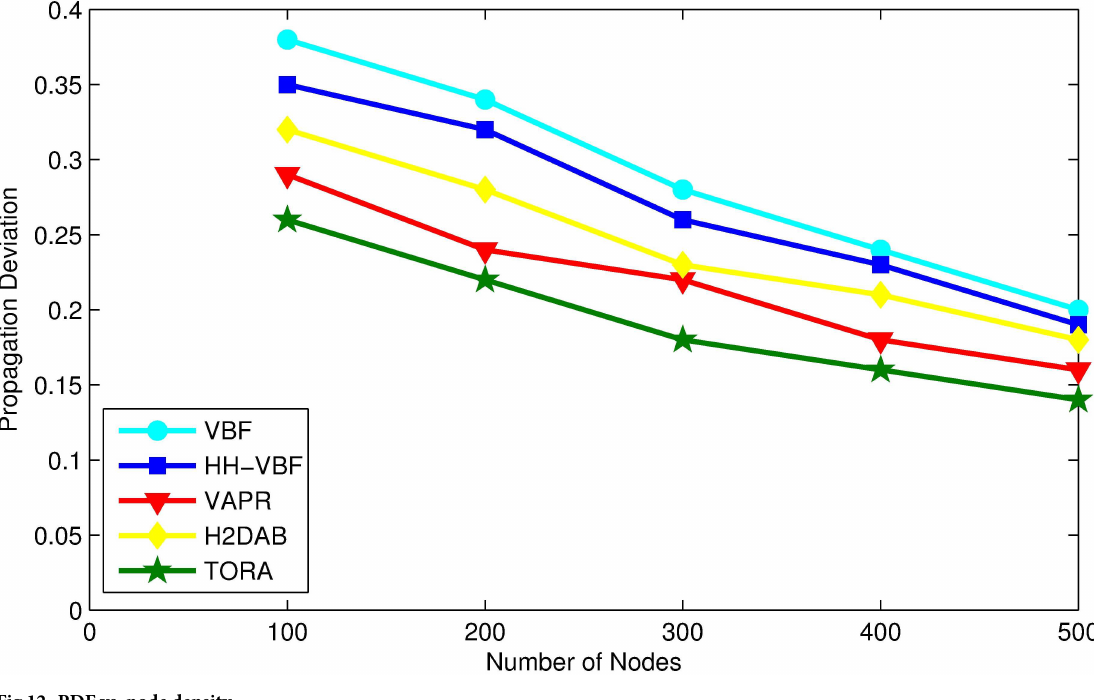
Fig 12. PDF vs. node